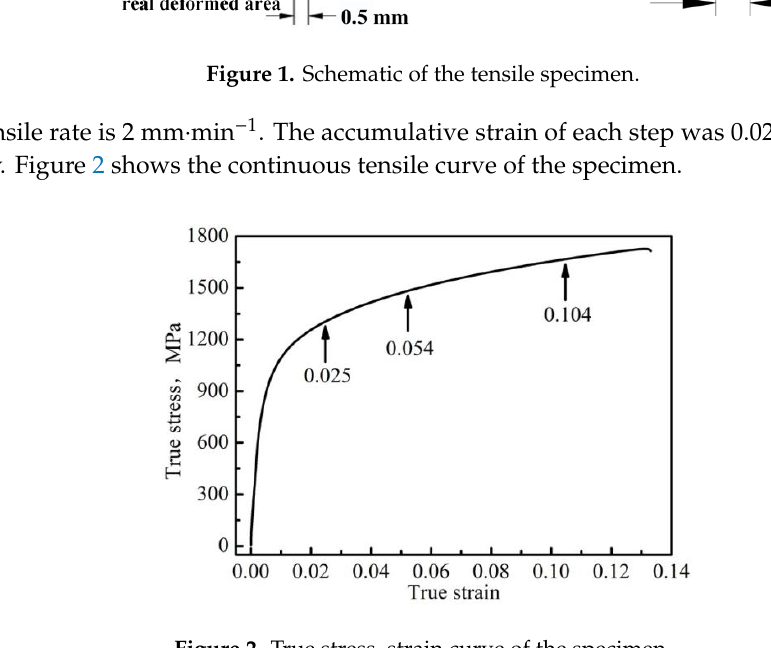
Figure 2. True stress–strain curve of the specimen.